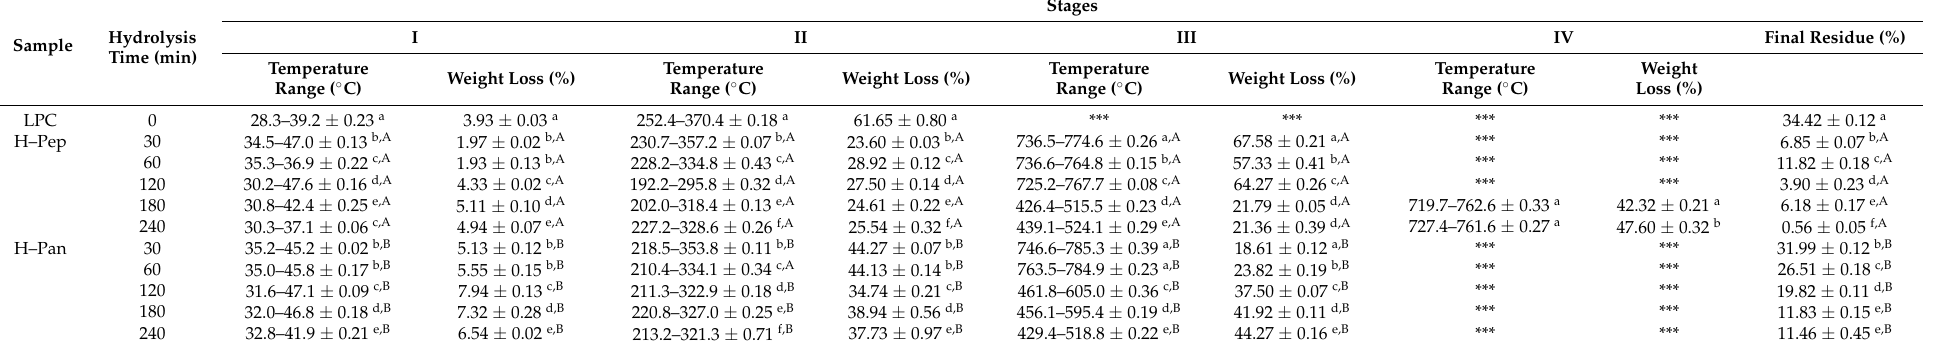
Table 3. Thermogravimetric analysis of the stages of decomposition of LPC and its